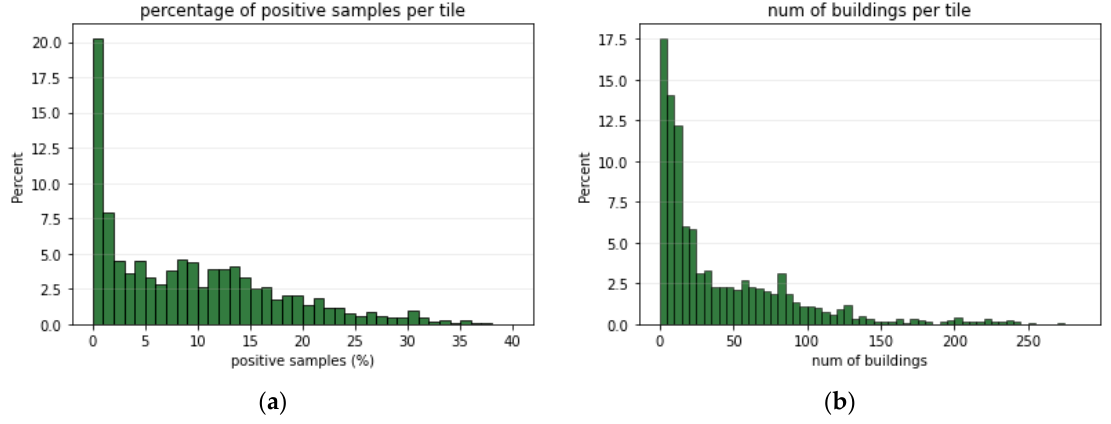
Figure 6. Per image tile statistics for the training set, normalized. ( a ) shows the distribution of positive samples compared to the total number of pixels in an image tile and 20% of tiles have less than 1% of total pixels categorized as buildings. ( b ) shows the number of buildings count for each image tile. Most tiles (17.5%) contain less than 5 buildings.